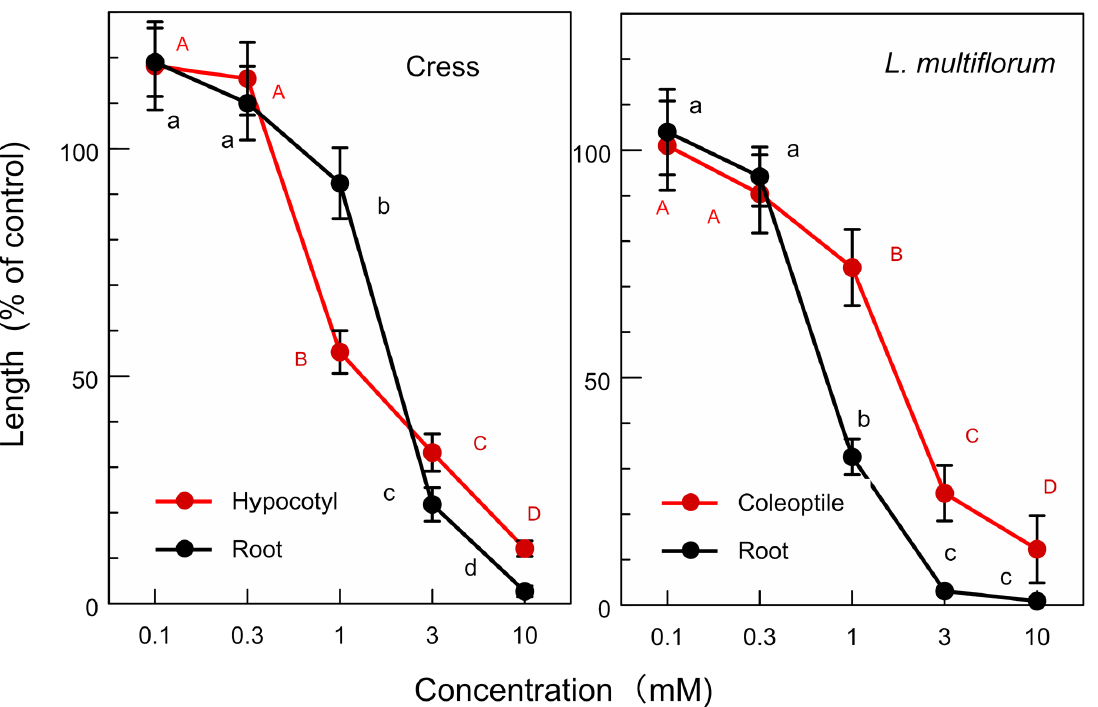
Figure 6. Chemical structure of (+)-pinoresinol.